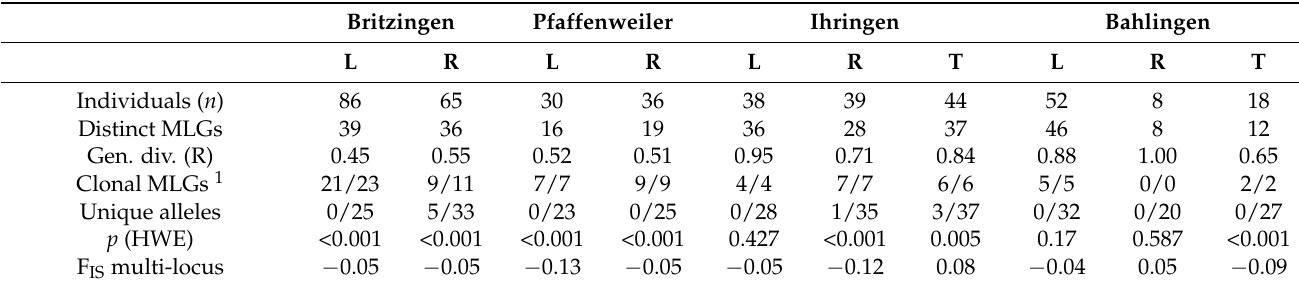
leaf populations was higher than those of the leaf sampling in the corresponding thickets (scenario 1). Table 2. Genetic diversity parameters for phylloxera leaf (L) and root (R) populations in vineyards and leaf populations in nearby thickets (T) covered with wild growing rootstocks, sampled in in 2018.